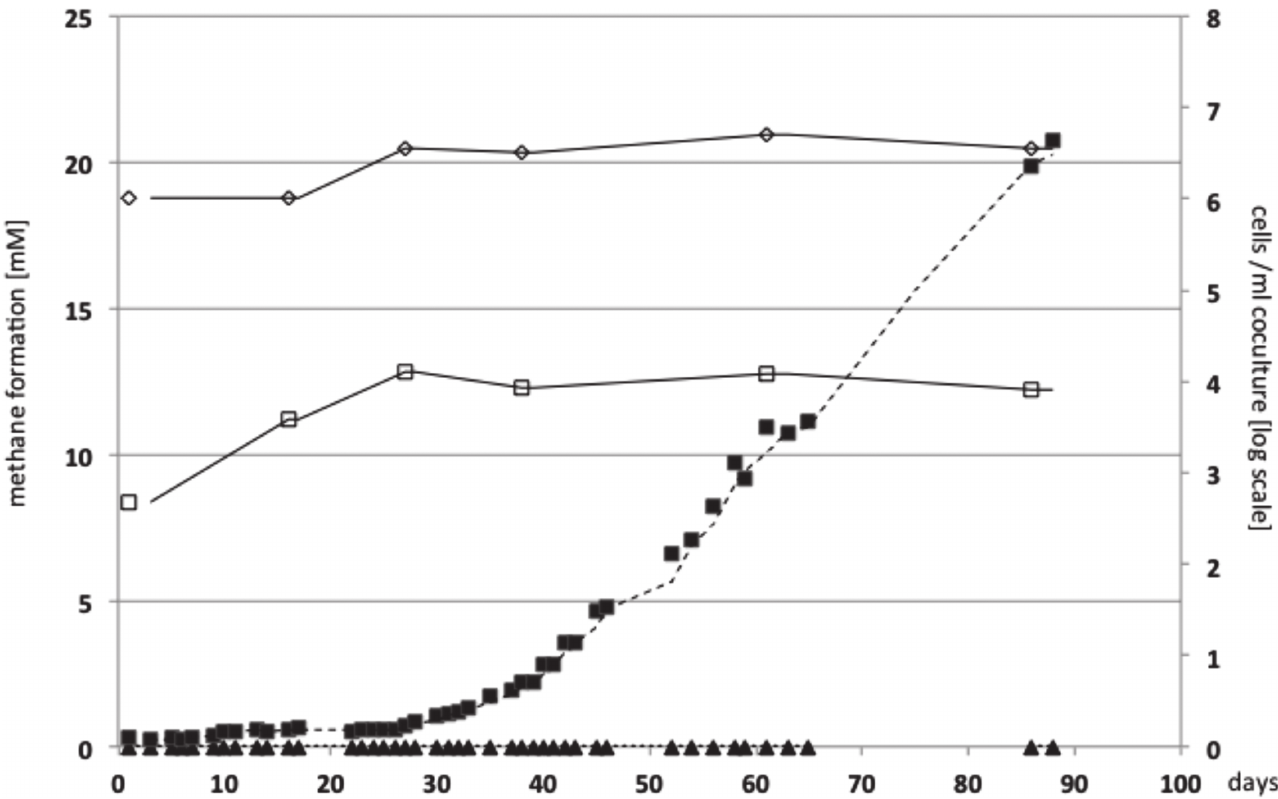
Fig 2. Acetate oxidizing co-culture consisting of SAOB and Methanoculleus species MAB2 cultivated, as described in the “ Material and methods ” section (flocs are between 2 mm and 5 mm in